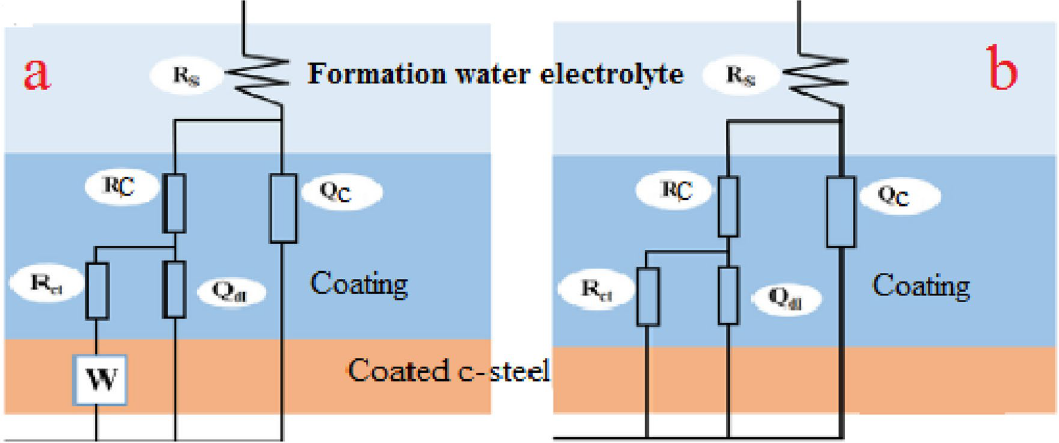
Figure 6. The suggested model for the equivalent circuit used for fitting the impedance parameters of coating systems in oil-wells formation water.